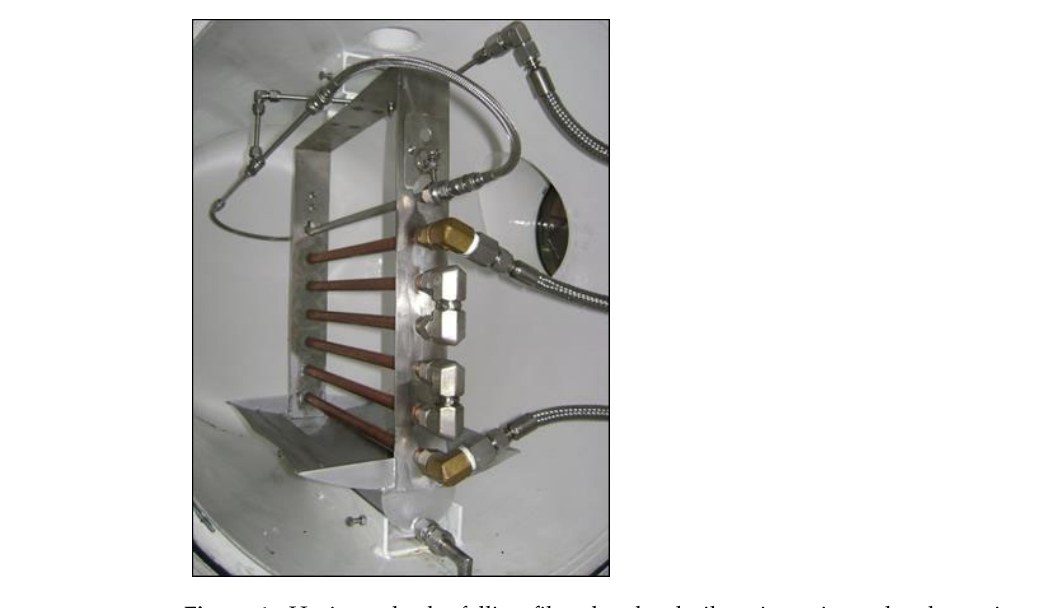
Figure 1. Horizontal tube falling ‐ film absorber built to investigate the absorption process with alkaline nitrate solution [19,20].